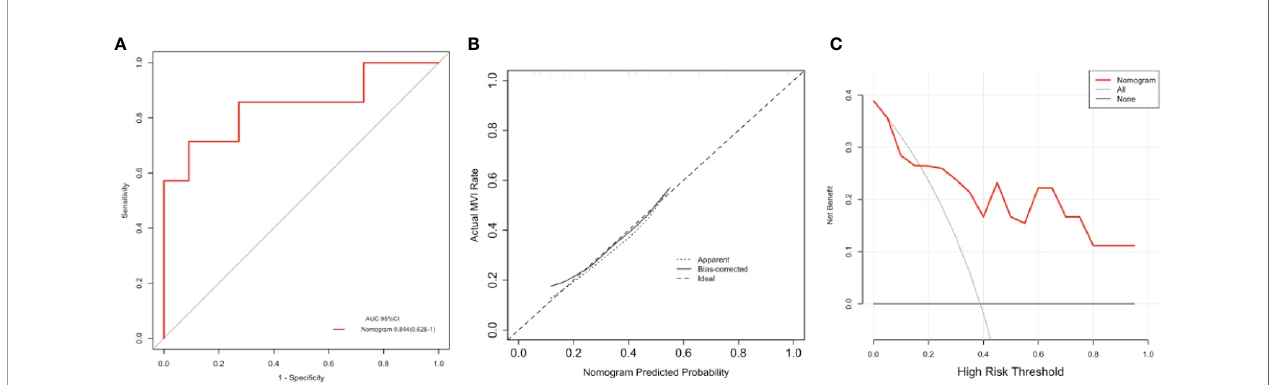
FIGURE 5 | The area under the curve (AUC) (A) , calibration curve (B), and decision curve analysis (DCA) (C) of the nomogram to prospectively analyze the pilot cohort. This purposed radiomics feature-based nomogram was able to predict tumors combined microvascular invasion (MVI) occurrence with an AUC of 0.844 (95% con fi dence interval:0.628 – 1.000) (A) the result calibration curve showed that the radiomics nomogram was with the ideal line (B) and as to result of the DCA represented that at the situation where the threshold probability was within a range from 0.2 to 1.0 (C) , this purposed nomogram obtained greater net bene fi t than either “ treat none ” or “ treat all ” scheme, suggesting that this purposed nomogram is still a good clinical